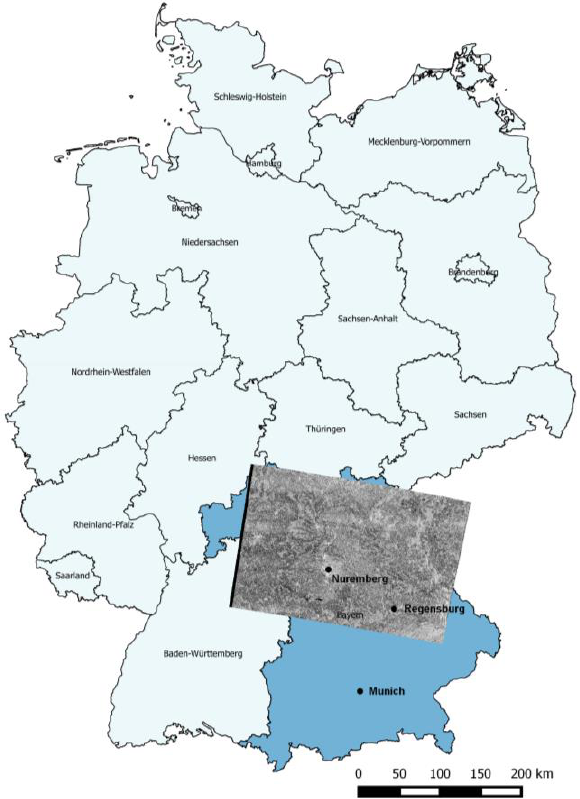
Figure 2. Spatial coverage of the Sentinel-1a image from 20 Jul. 2015. Background map © BKG open data